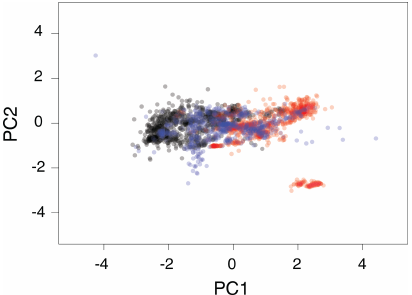
Figure 6. Modern and ancient data projected onto the first two com- positional principal components. Black: modern; blue: Eocene (In- glis et al., 2015); red: Cretaceous (O’Brien et al., 2017).